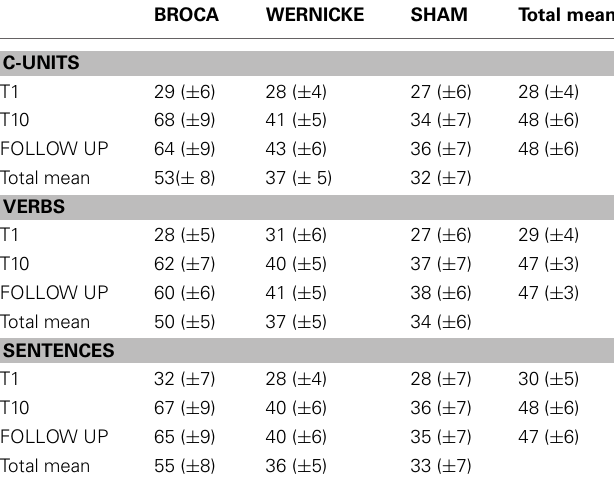
FIGURE 3 | Mean percentage of correct “C-Units” at baseline (T1) and at the end of treatment (T10) for the left anodic Wernicke’s, Broca’s and sham conditions ( ∗ < 0.01), respectively. Error bars represent standard error of the mean. Table 3 | Mean percentage of correct C-Units, Verbs and Sentences ( ± SEM) for the 12 aphasic participants at the baseline (T1), at the end of treatment (T10) and at follow-up (1 month after the end of treatment) for the Broca’s, Wernicke’s and sham condition, respectively (SEM = error standard of the mean).